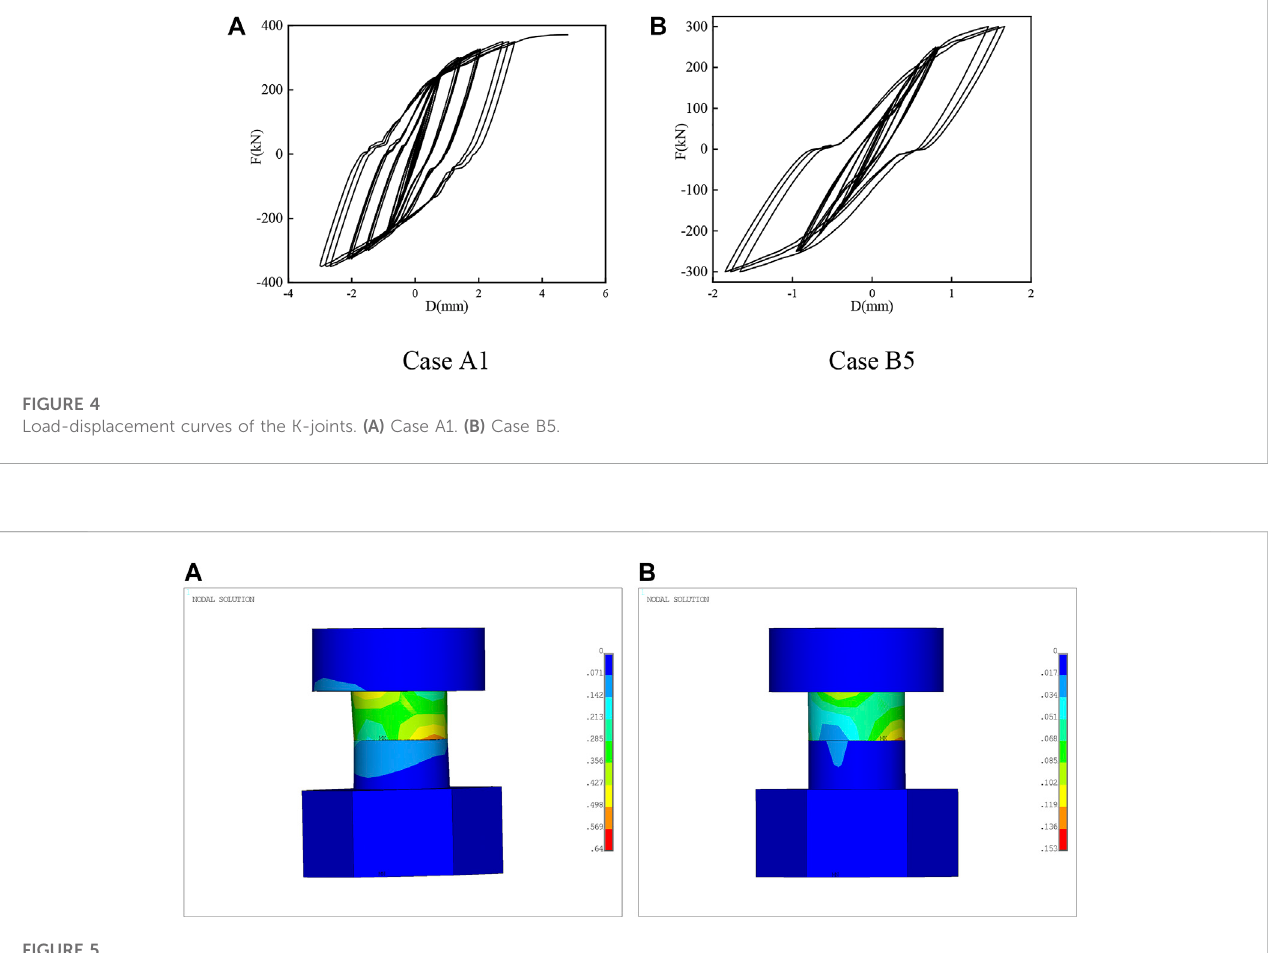
Bolt plastic strain of Case A1. (A) the bolt of branch angle steel, (B) the bolt of main angle